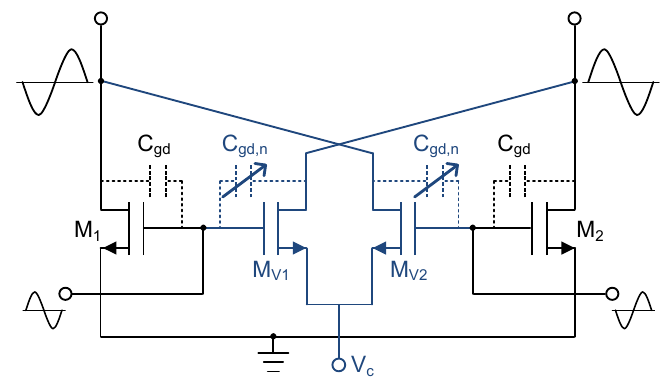
Figure 4. Proposed tunable neutralization technique using a cross-coupled MOS − varactor pair.